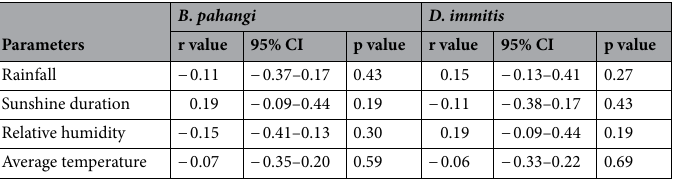
Table 2. Showed the correlation of environmental parameters between B. pahangi and D. immitis using Pearson’s correlation.